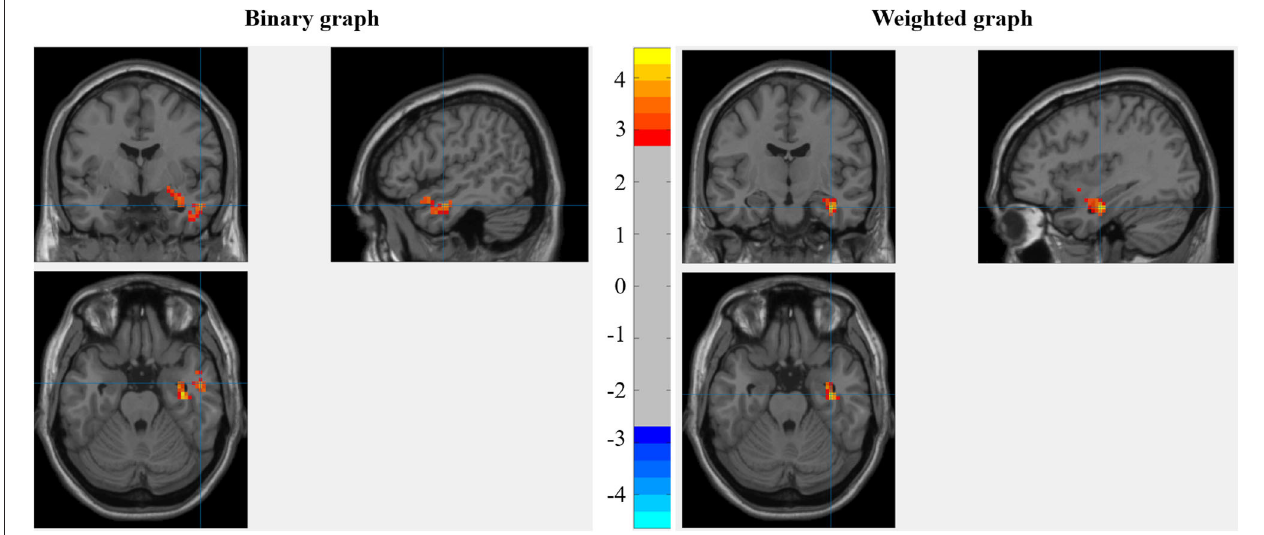
FIGURE 4 | The modulating roles of ST on the relationships between RSDC and MC score.